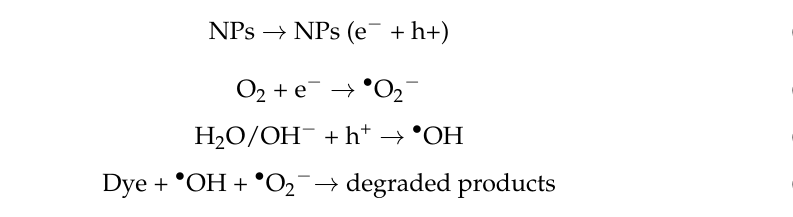
Table 1. Comparison of the photodegradation of MB dye by our photocatalysts and Fe2O3-based photocatalysts in the